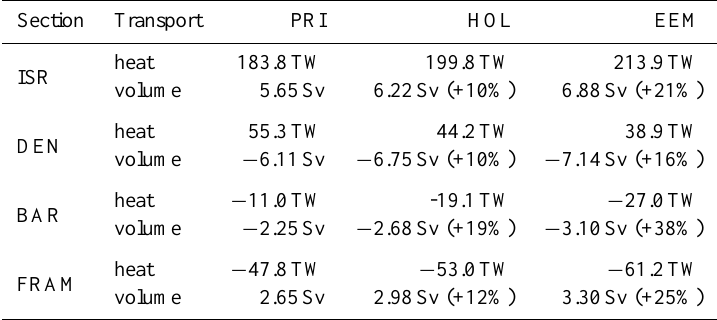
Table 1. Heat transports (in TW − 10 12 W), volume transports (in Sv − 10 6 m 2 /s), and changes in volume transport with respect to the pre- industrial transports (in %) into (pos.) and out of (neg.) the Nordic Seas through the passages depicted in Fig. 8. Increasing negative values for BAR and FRAM indicate increased heat transports into the